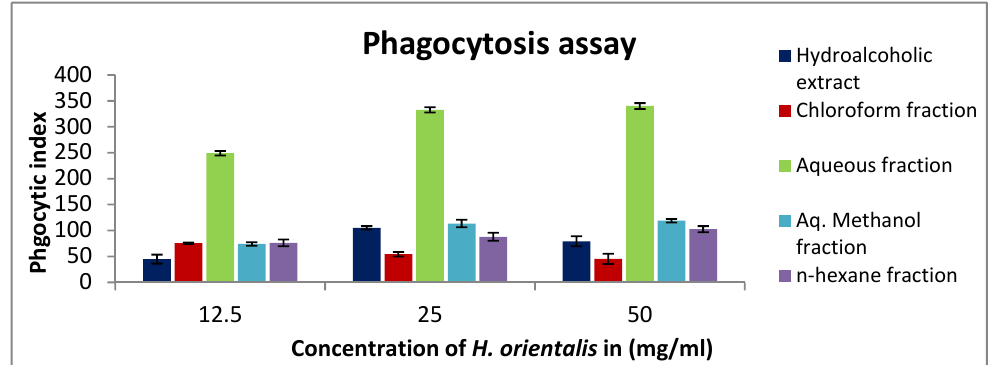
Figure 4. In vitro phagocytic assay using nitro blue tetrazolium (NBT) reduction test of peritoneal macrophages treated